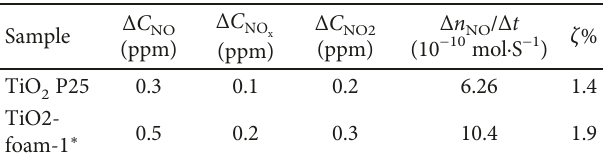
Figure 5: Concentration changes of NO, NO , and NO as a function of UV illumination time in a typical experimental run for a AEROXIDE 2 x P25 (a) and TiO -foam-1 (with hexylic acid) sample (b). 2 Table 1: Concentration changes and calculated photonic e ffi ciencies ( ζ